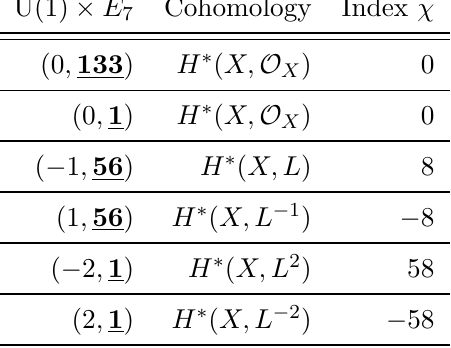
Table 2. The chiral spectrum for the hidden sector U(1) × E 7 with a single line bundle L = O X (2 , 1 , 3) . The Euler characteristic (or index) χ gives the difference between the number of right- and left-chiral fermionic zero-modes transforming in the given representation. We denote the line bundle dual to L by L − 1 and the trivial bundle L 0 by O X